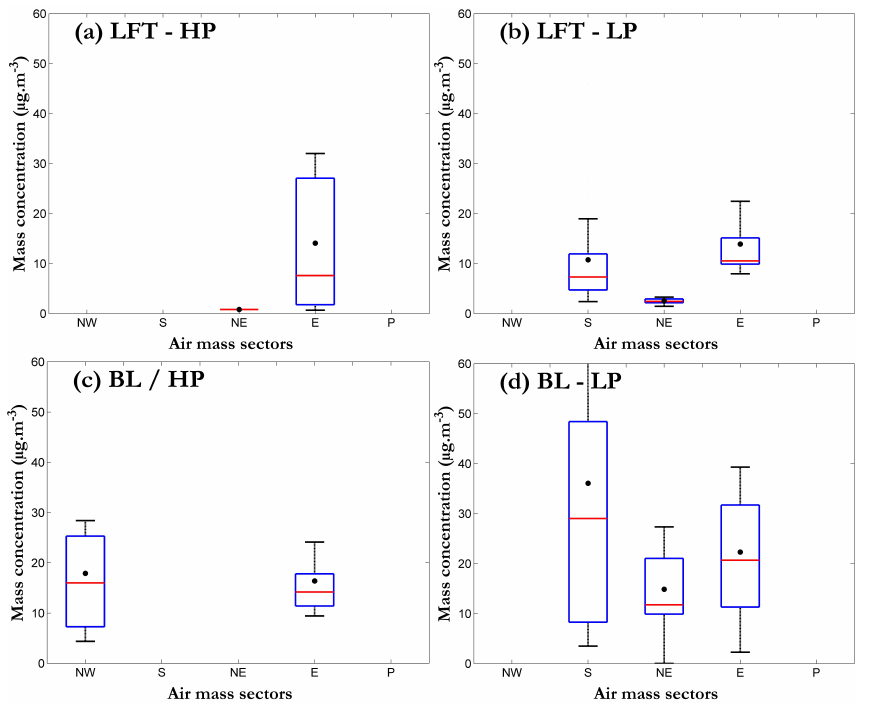
Fig. 6. Mass concentration of submicron non-refractory aerosol as measured by AMS as a function of the air mass origin (NW: north-West Europe; S: south Europe; NE: north Europe; E: east Europe; P: polar) in the lower free troposphere during anticyclonic (HP, a ) and cyclonic (LP, b ) conditions as well as in the boundary layer during anticyclonic (HP, c ) and cyclonic (LP, d ) conditions. Lower and upper limits of the box correspond to 25% and 75% percentiles, bottom and top whiskers the 5% and 95%. Middle bars indicate the median. Black points represent the averaged total mass concentration (including the mass of refractory material (exposed to high temperature) derived from the aerosol volume distribution and a density of 1.8gcm − 3